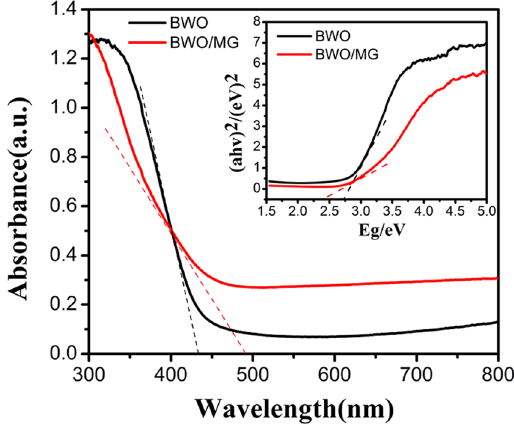
Figure 5. UV-vis diffuse reflectance spectra (DRS) for BWO and BWO/MG (inset presents the corresponding plots of transformed Kubelka − Munk vs energy of